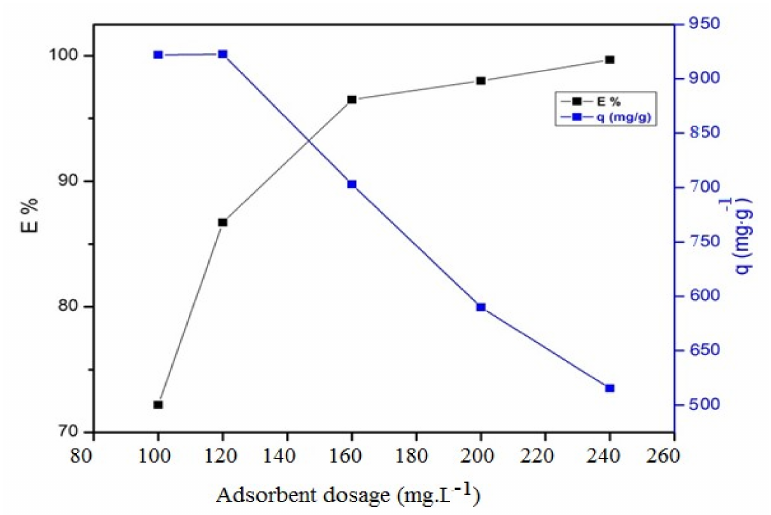
Figure 11. E ff ect of QVP / AAm-Fe 3 O 4 dosage on the adsorption capacity and removal e ffi ciency of CR for optimum contact time and room temperature.